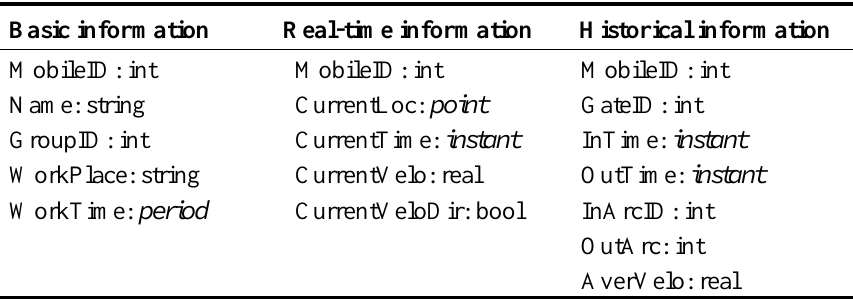
Table 3. The personnel information data